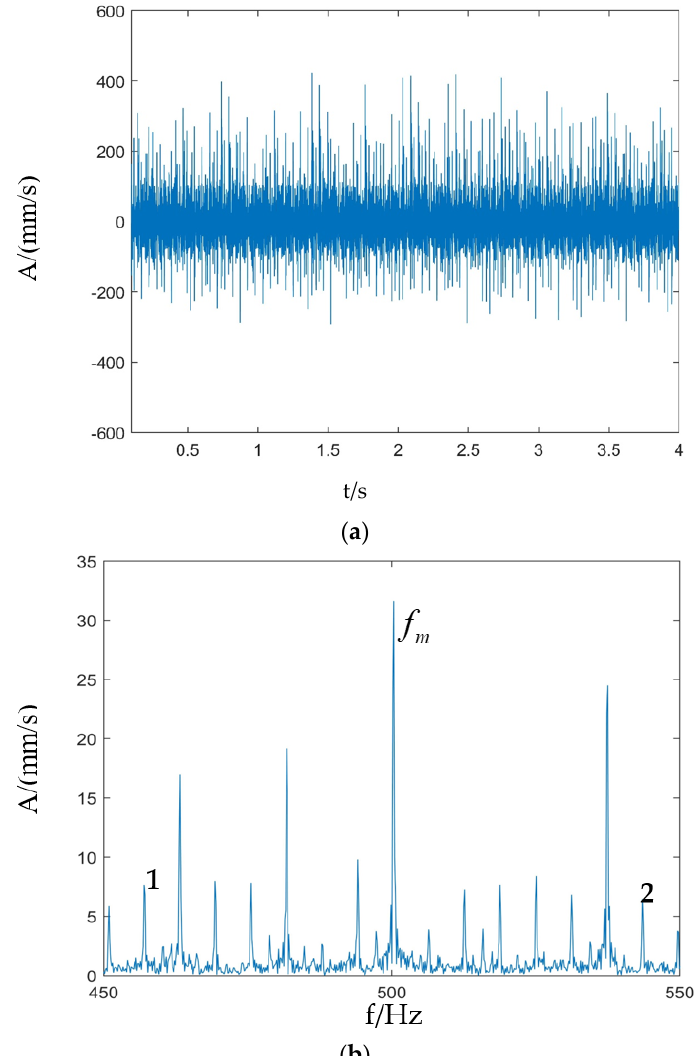
Figure 7. Normal simulation vibration signal of sun gear and planetary gear : ( a ) Time domain waveform; ( b ) Fourier spectrum.